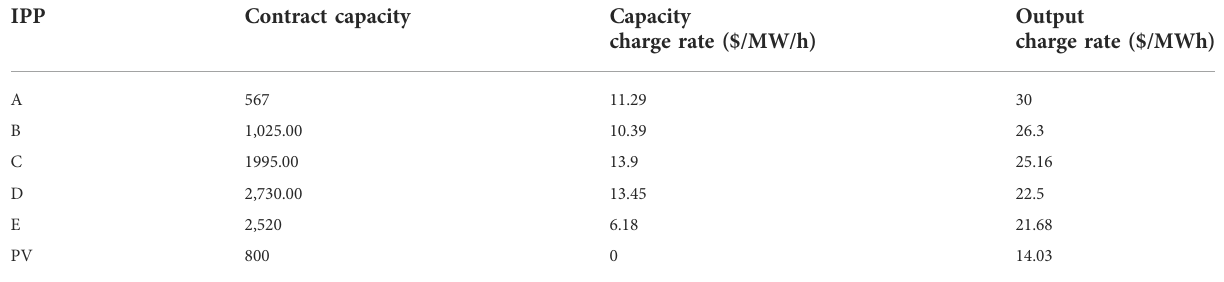
TABLE 4 Capacity and output charge rates.